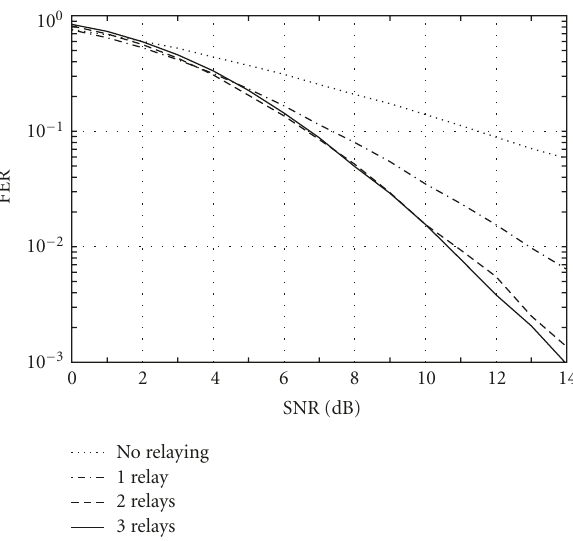
Figure 8: QPSK, 8 states ( μ = 4), generators as in Tables 3 and 4 with and without one relay, 2 transmitting antennas per node, 1 receiving antenna, in quasistatic fading channel.